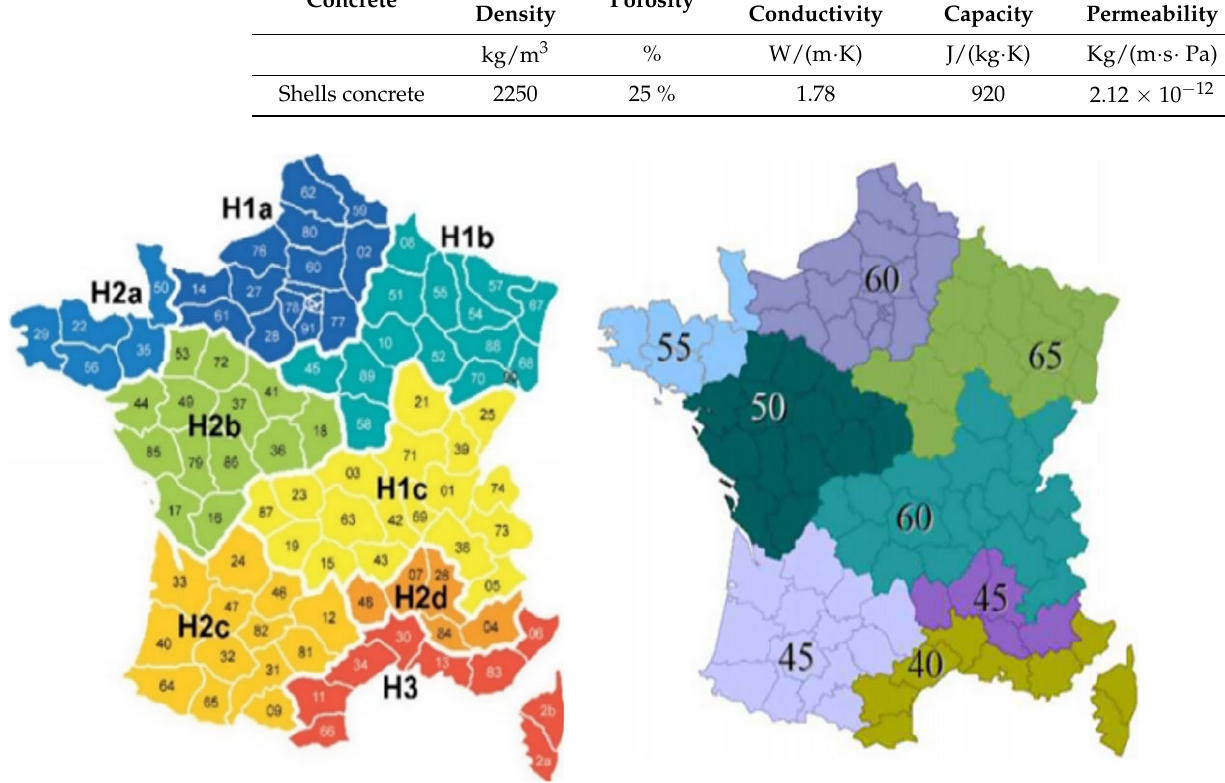
Figure 5. Map of climatic zones and Maximal energy demand